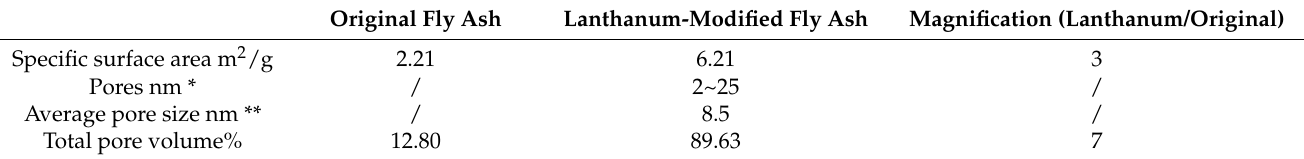
Table 3. Lanthanum modified fly ash specific surface area pore volume multiplier.